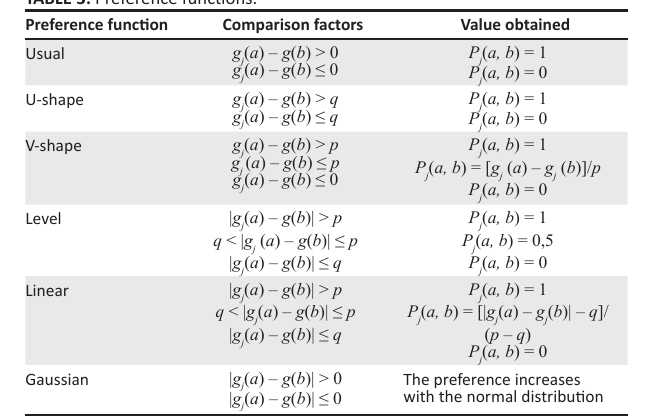
FIGURE 2: Method